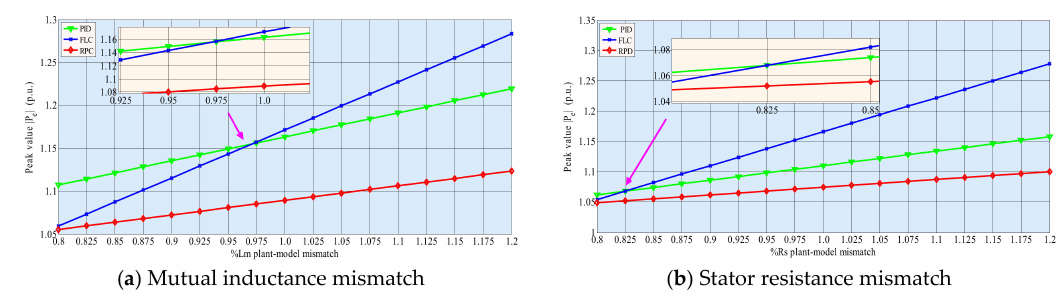
Figure 8. Peak value of active power | P e | obtained under a 0.2 p.u. voltage drop lasting 0.1 s at power grid with 20% variation of the stator resistance R s and mutual inductance L m of three approaches, respectively. ( a ) mutual inductance mismatch; ( b ) stator resistance